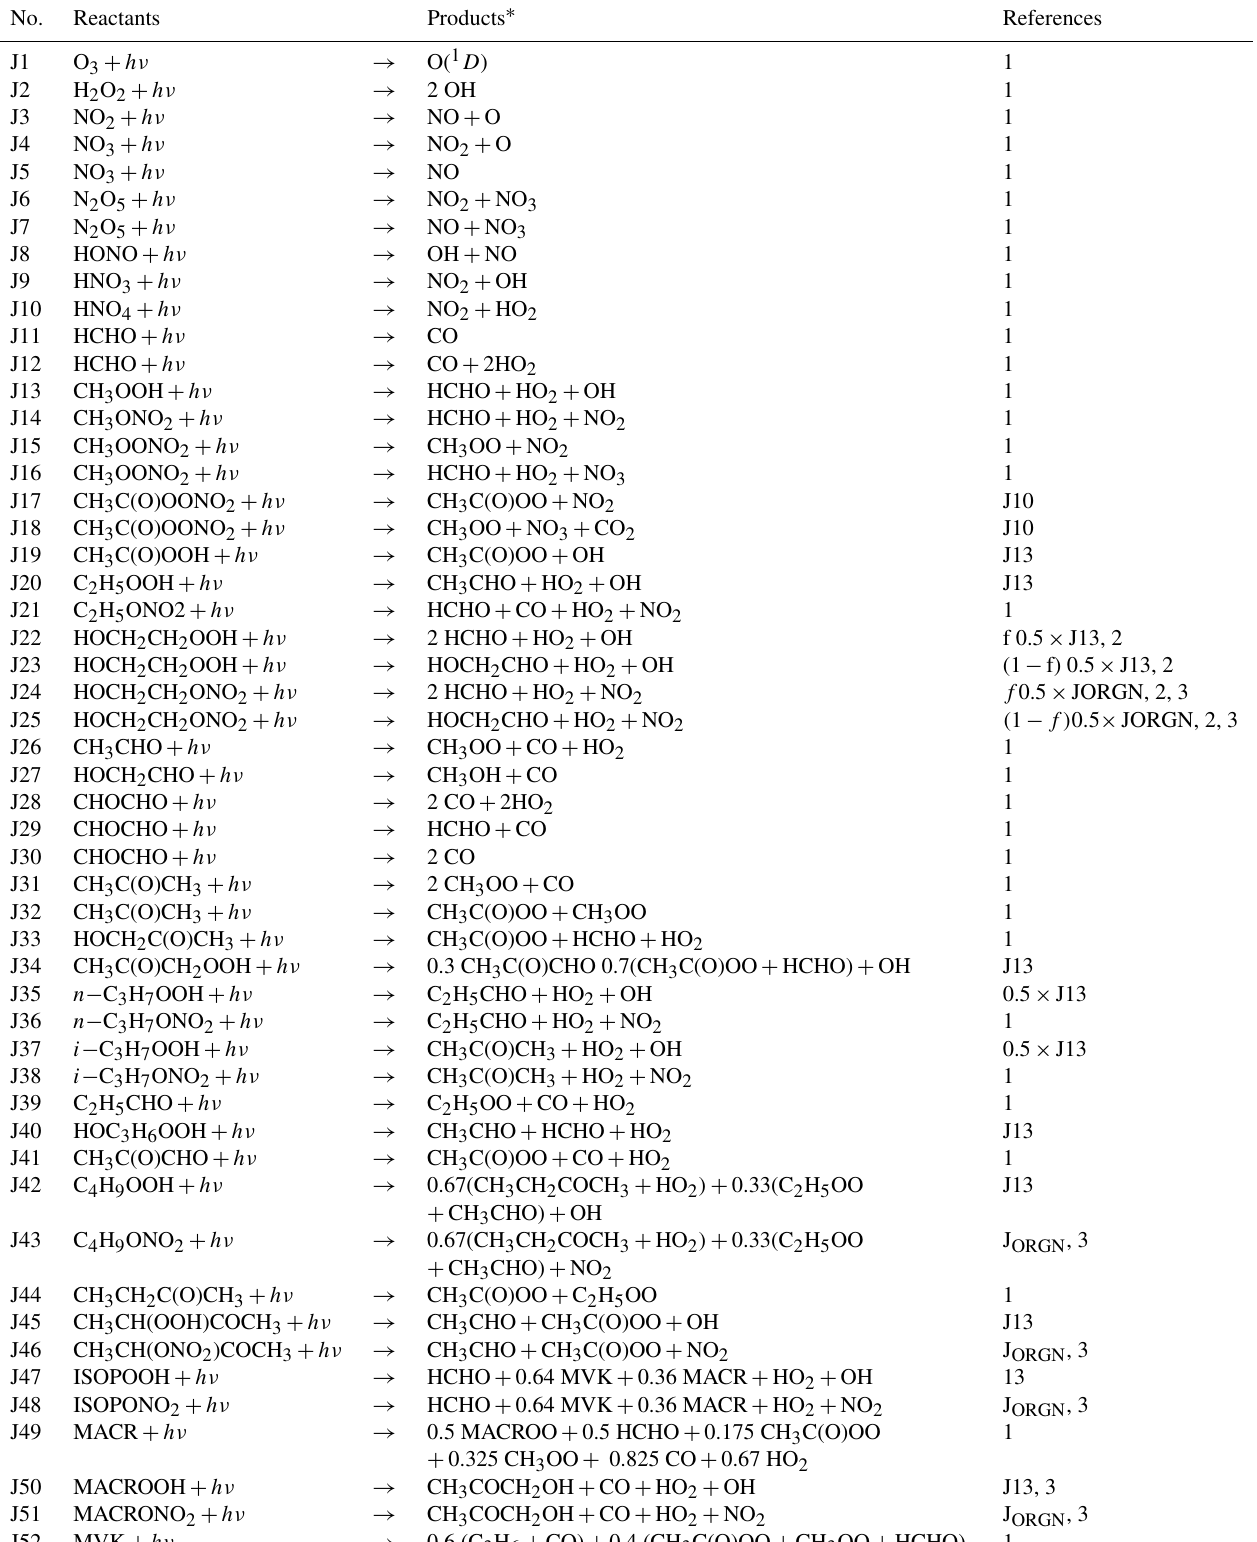
Table 1. Photolysis reactions (J) in the MOGUNTIA chemistry